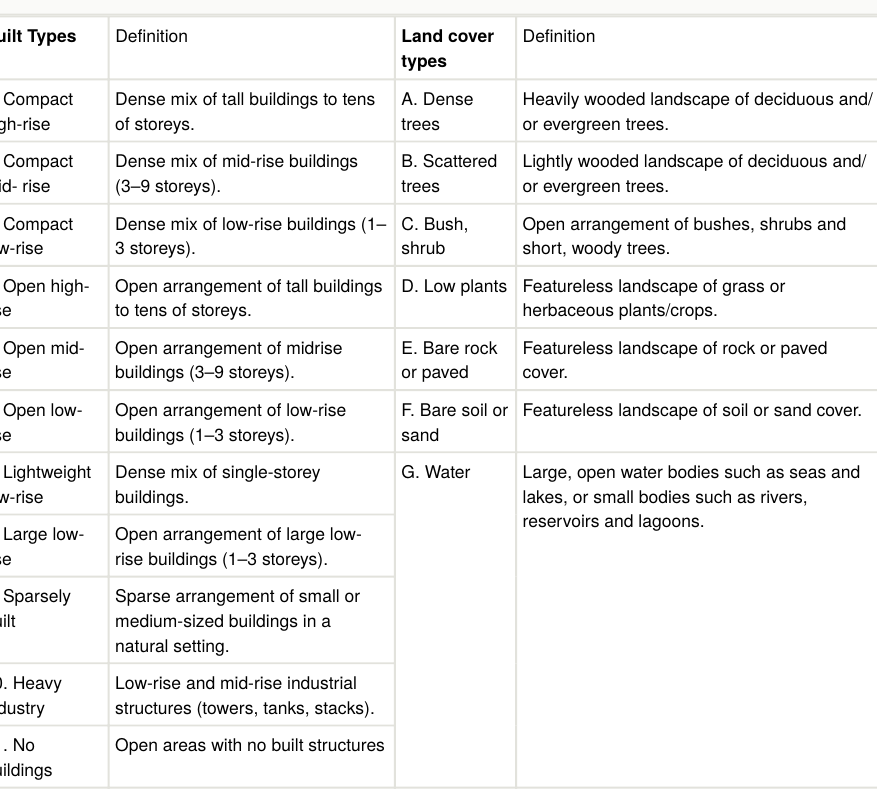
Built types and land cover types (after Stewart and Oke 2012 with modi fi cation according to national speci fi